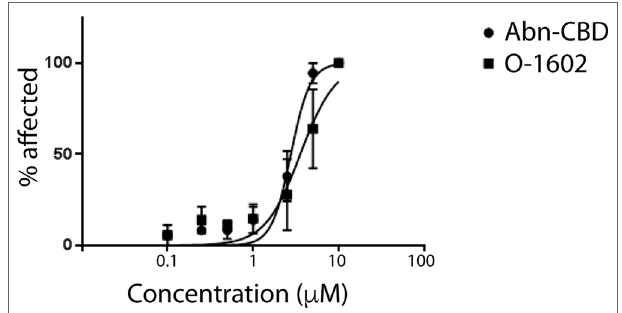
FIGURE 7 | Toxicity of atypical cannabinoids in zebrafish. Graph showing the percentage of zebrafish larvae affected by various concentrations of O-1602 or Abn-CBD in water for 3